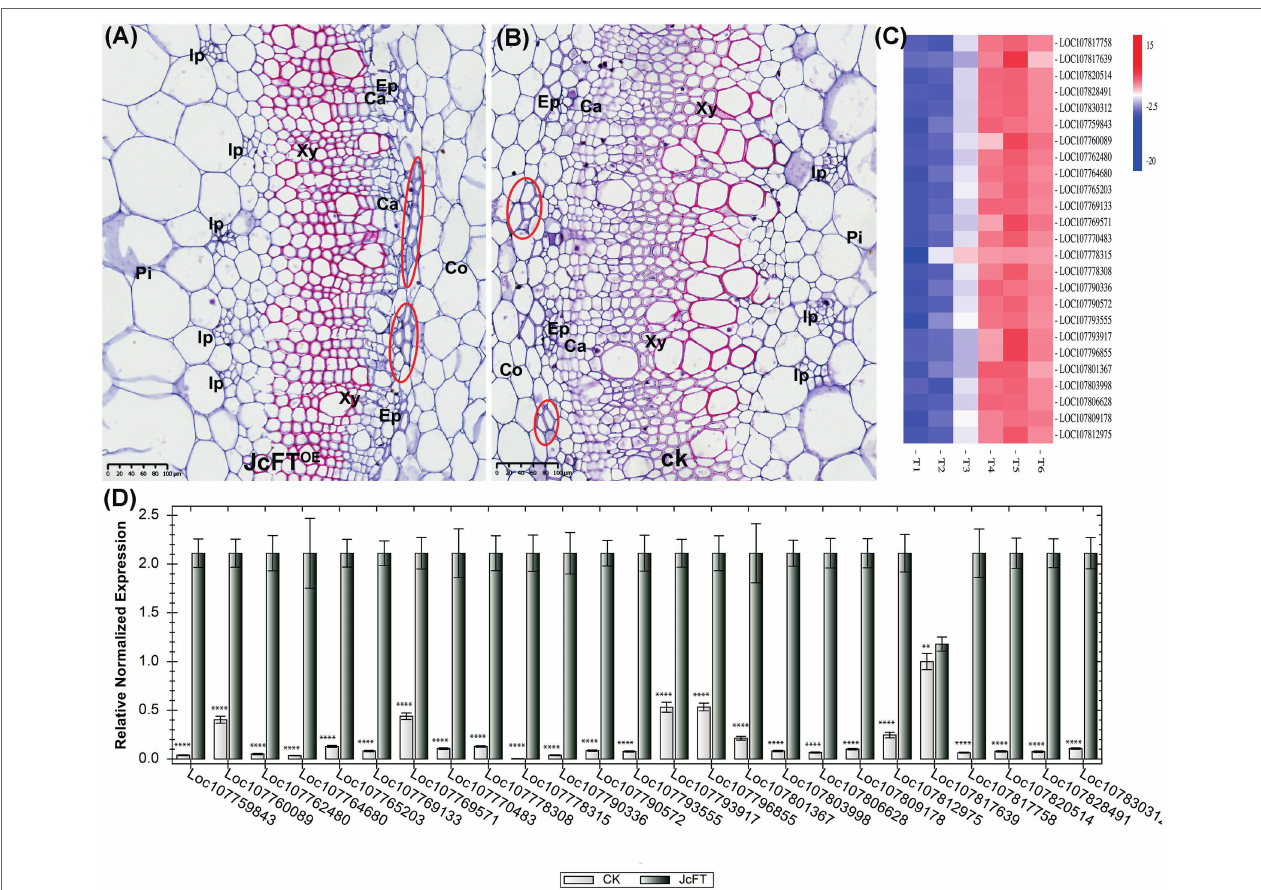
FIGURE 9 | Development of stem vascular bundles in JcFT OE and control plants. (A,B) Stem cross sections (same magnification) of JcFT OE and control plants at 49 days after seeding (scale bar = 50 μ m). Whereas JcFT OE plants have five smaller internal phloem bundles, control plants have three larger internal phloem bundles. Circles indicate fiber cells in the external phloem. (C) Expression heat map of 25 differentially expressed genes identified as IRX genes. Control samples: T1, T2, T3; JcFT OE samples: T4, T5, T6. Blue indicates a decrease in expression; red indicates an increase in expression. (D) Reverse-transcription qPCR verification of 25 differentially expressed IRX genes (bars represented gene expression mean and standard error of mean, n = 3, ** p < 0.01, **** p < 0.0001, and the corresponding gene accession number was under the bars). CK: control; Pi: pith, Co: cortex, Ph: phloem, Ca: cambium, Xy: xylem, Ip: internal phloem, Ep: external